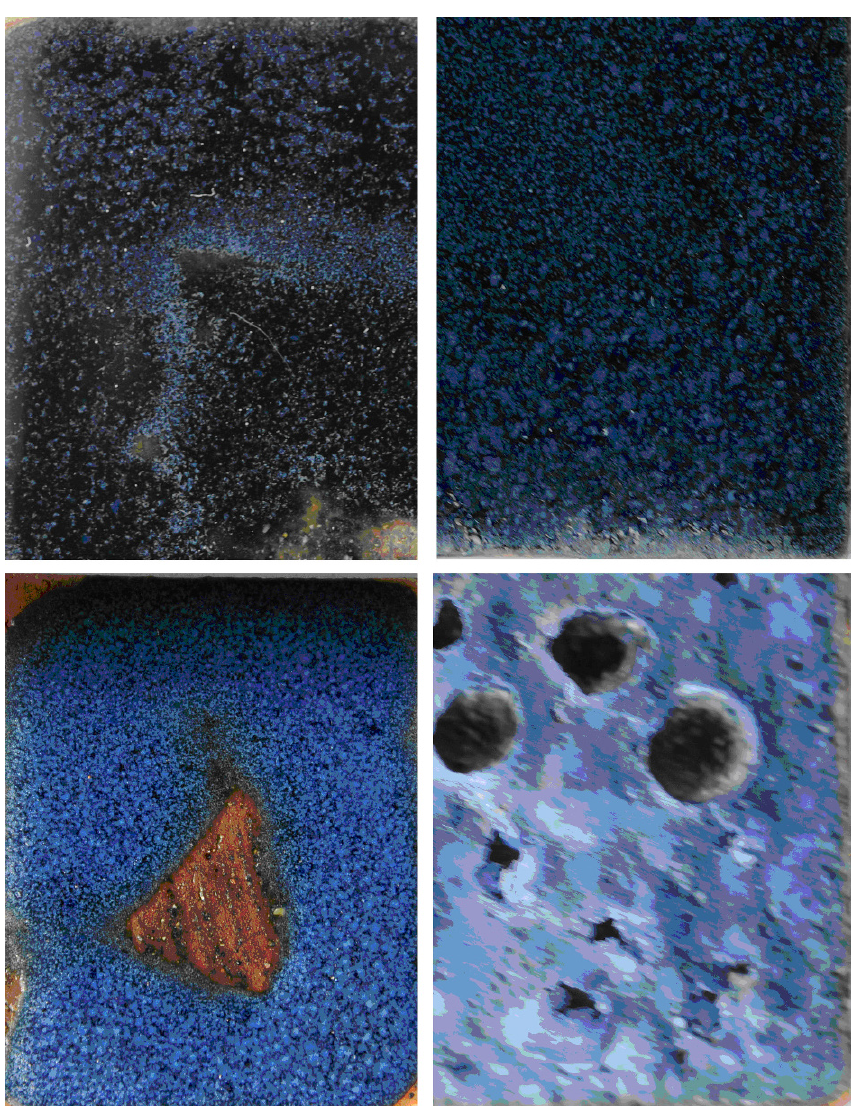
Figure 11. Photographs of sol-gel-derived glazes having different pigments: CoAl